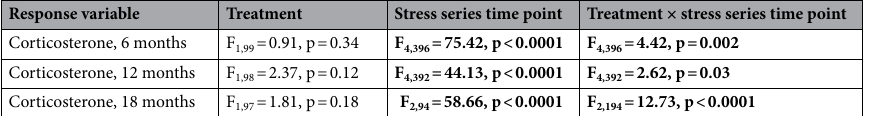
Table 1. Results of generalized linear mixed models (GLMM) analyzing the response to treatment (control or 5 ng corticosterone), and stress-series time point (baseline, stress-induced, dexamethasone-suppression, ACTH challenge, and final recovery for 6 and 12 months; and baseline, stress-induced, and recovery for 18 months), and their interaction on corticosterone concentrations. Bold values indicate p <